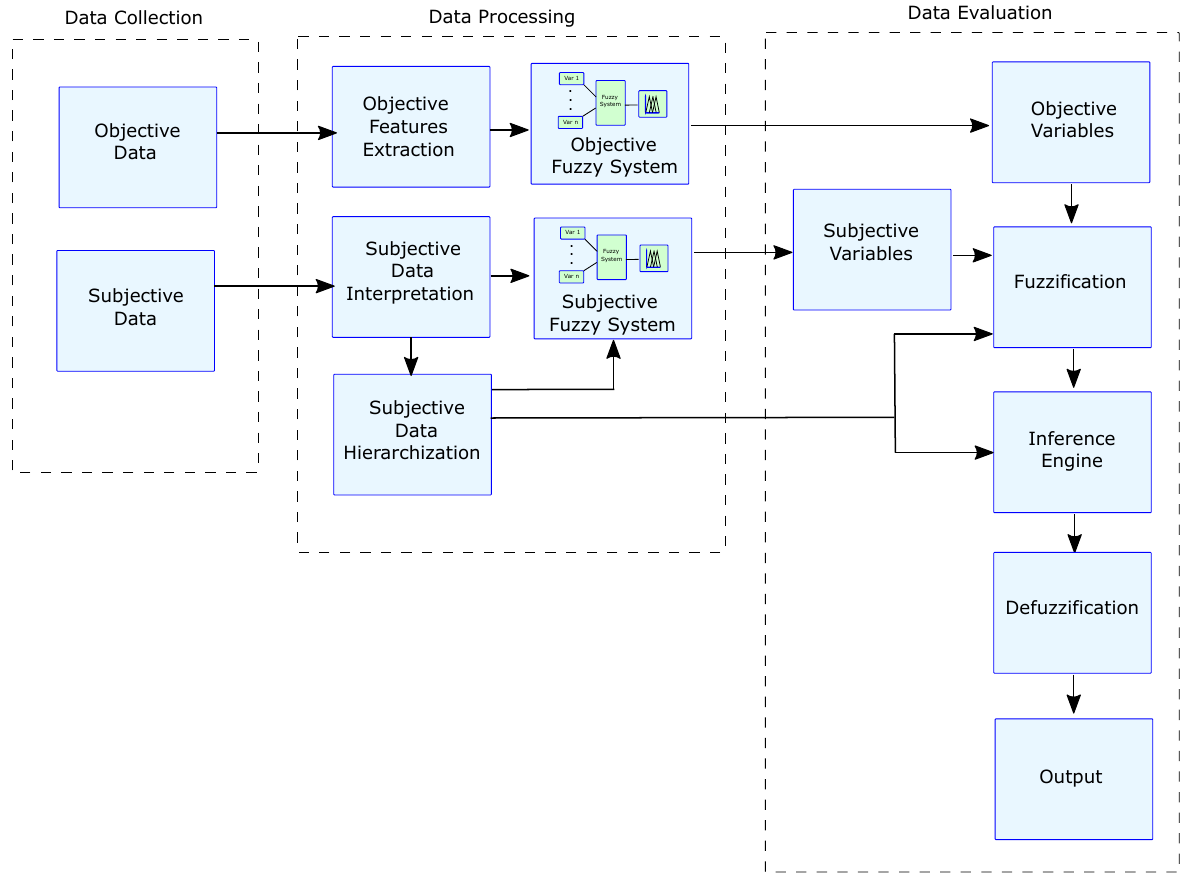
Figure 1. Reference